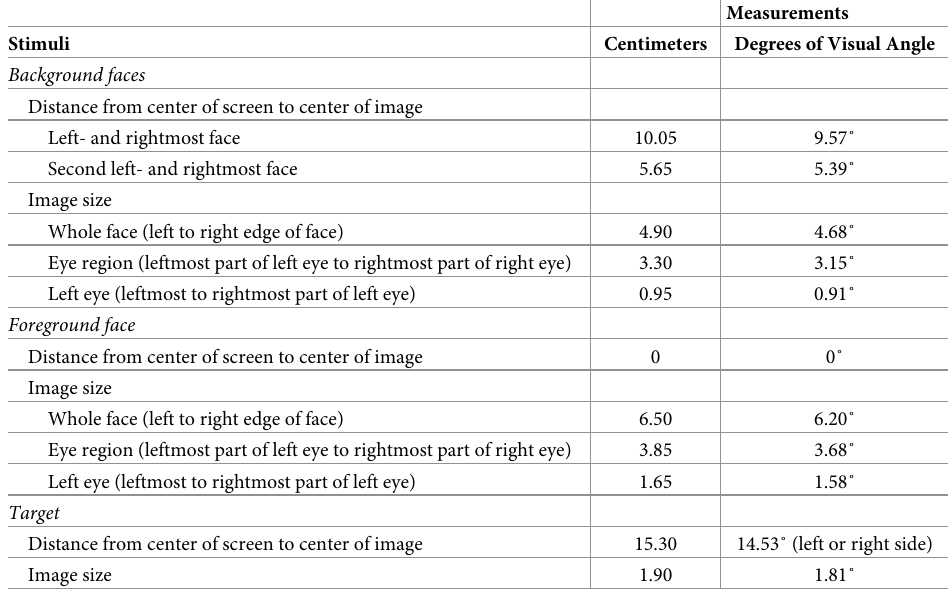
Note : Centimeters refer to size measured on the physical monitor. Degrees of visual angle (units to measure size of stimulus on the retina) were calculated with a distance of 60 cm between participant and